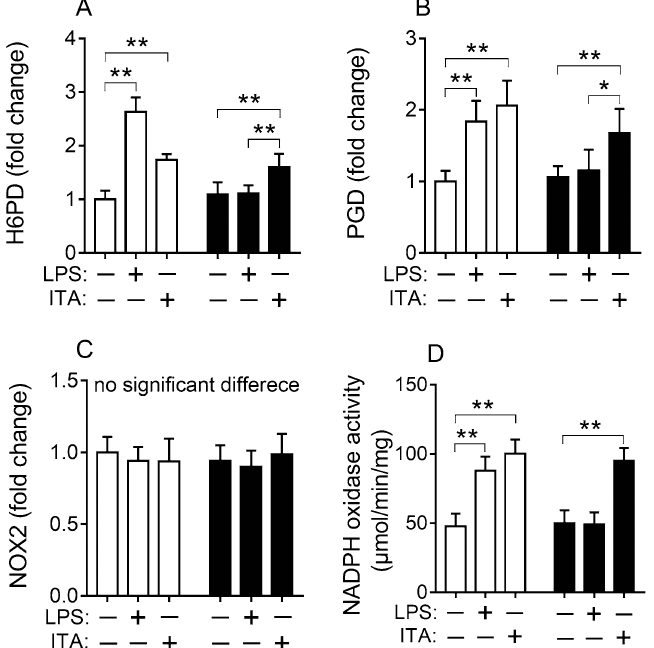
Figure 3. Relative expression of gene H6PD ( A ), PGD ( B ), NOX2 ( C ) and NADPH oxidase activity ( D ) in RAW264.7 and RAW264.7-IRG1KO cells with different treatments (24 h). White bar, RAW264.7; black bar, RAW264.7-IRG1KO. LPS, lipopolysaccharide; ITA, itaconic acid. H6PD , glucose 6-phosphate dehydrogenase; PGD , 6-phosphogluconate dehydrogenase; NOX2 , NADPH oxidase 2. Relative gene expression level of cells with different treatments was normalized to RAW264.7 control and represents the fold change. Values represent the mean ± S.E.M. *, p < 0.05; **, p < 0.01.